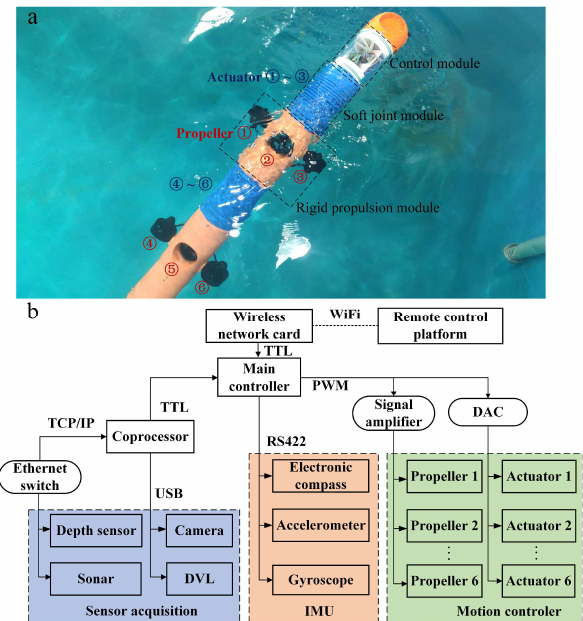
Figure 7. Mechanical and hardware configurations of the snake robot: ( a ) robot prototype; ( b ) control system.